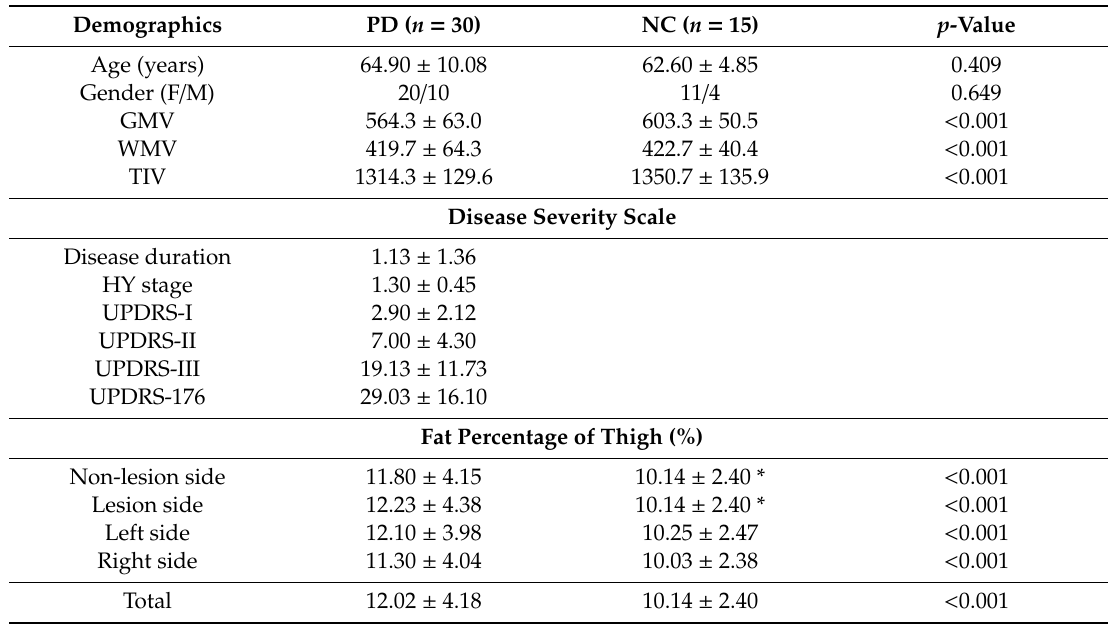
Table 1. Demographic and clinical data and fat percentage of core muscle of PD group and normal control